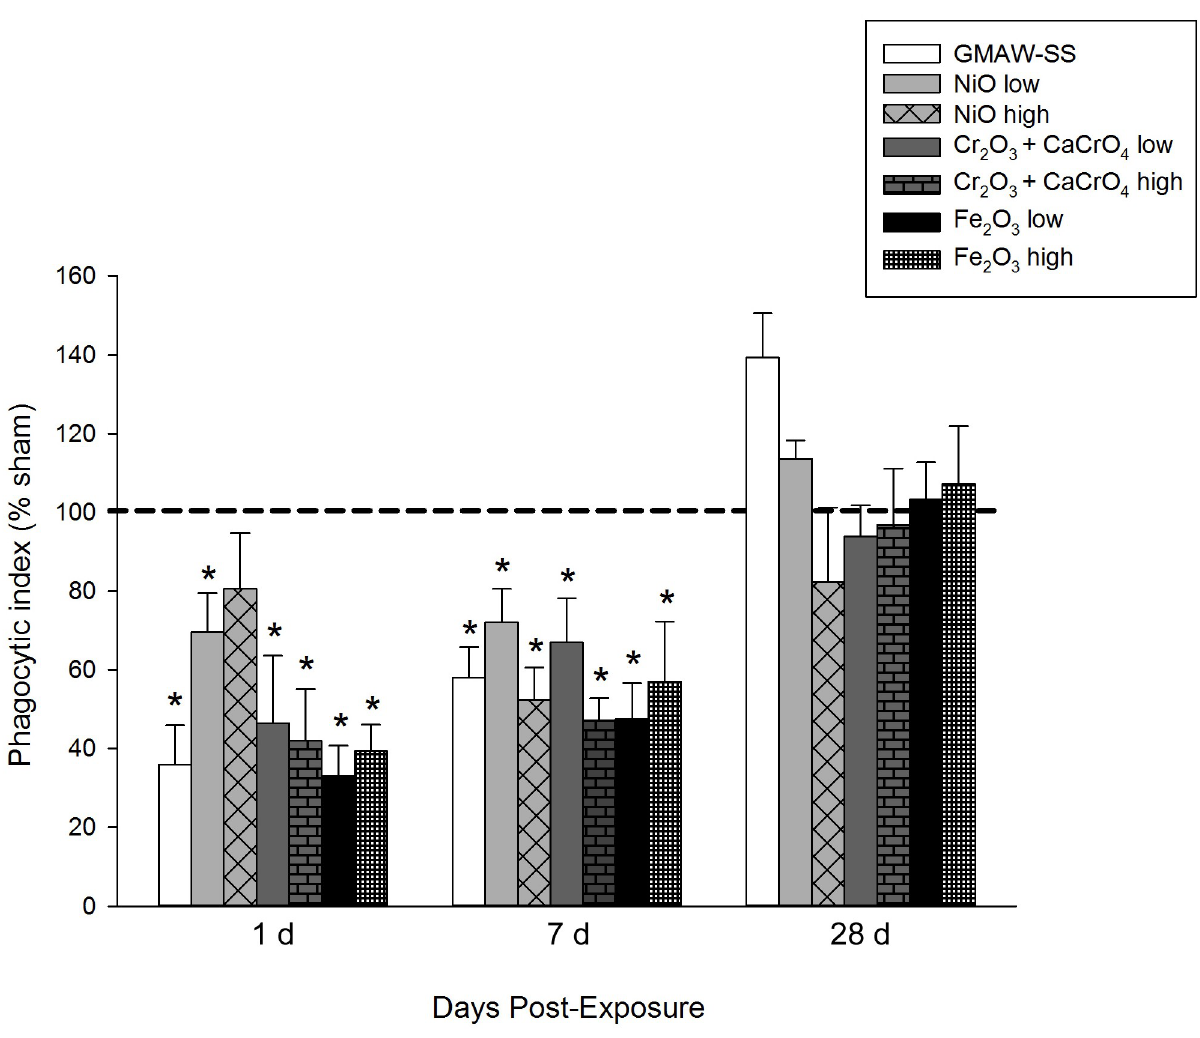
Fig 6. Ability of alveolar macrophages to phagocytose E . coli GFP after exposure to GMAW-SS fume or metal oxides. E . coli uptake by macrophages was quantified by flow cytometry. Data presented as percent change from sham (dashed line– 100%). � p < 0.05 compared to sham.